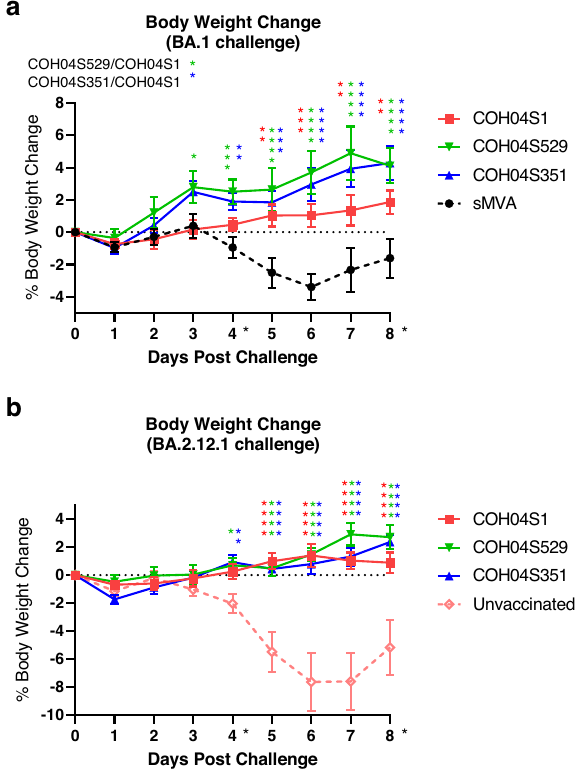
Fig. 2 COH04S1 and Omicron BA.1- and Beta-modi fi ed vaccines protect hamsters from weight loss following challenge with Omicron BA.1 or BA.2.12.1. Body weight of COH04S1, COH04S529-, COH04S351-vaccinated animals was measured daily for 8 days following challenge with Omicron variants BA.1 ( a ) and BA.2.12.1 ( b ). Hamsters vaccinated with empty sMVA vector or unvaccinated hamsters were used as controls. Weight loss compared to day 0 is reported as mean ±SEM. Two-way ANOVA followed by Tukey ’ s multiple comparison test was used to compare group mean values at each timepoint following log transformation. Color-coded asterisks indicate signi fi cant difference compared to controls unless speci fi ed. *0.05< p <0.01, **0.01< p <0.001, ***0.001< p <0.0001, **** p <0.0001. When not indi- cated, differences are not signi fi cant ( p >0.05). Black asterisks indicate time of sacri fi ce ( n =